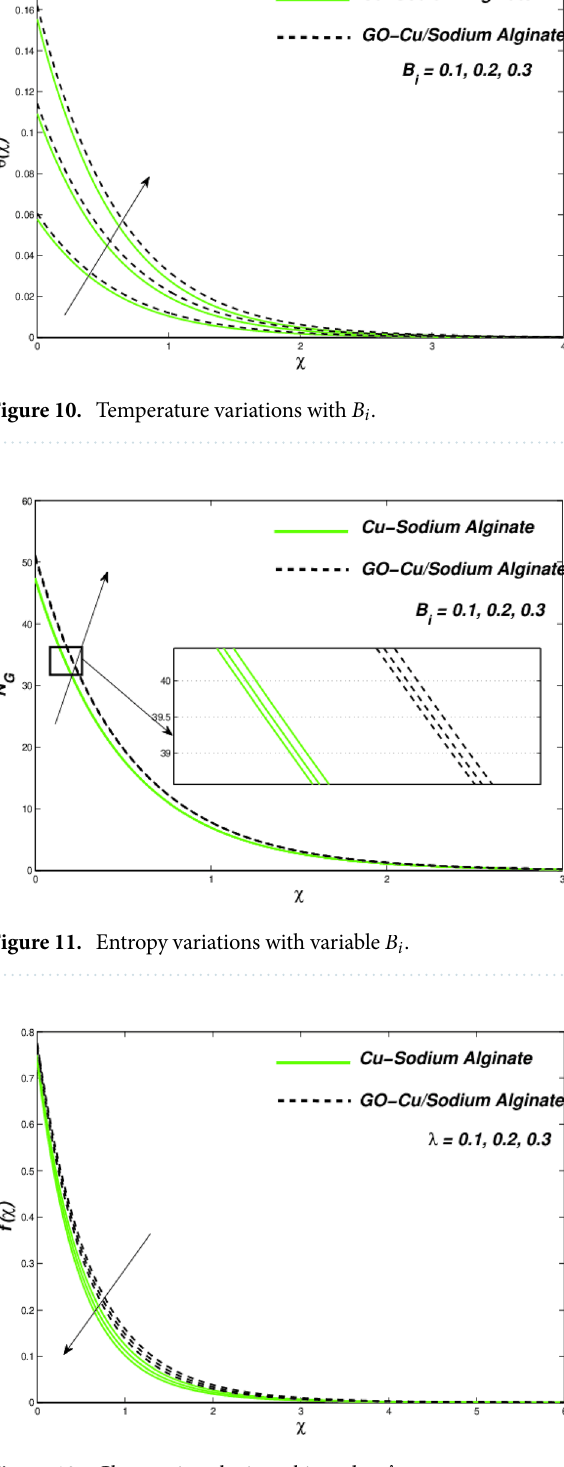
Figure 12. Changes in velocity subjected to (cid:31)